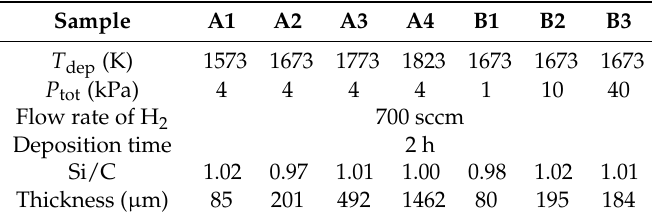
Table 1. Deposition conditions and chemical composition